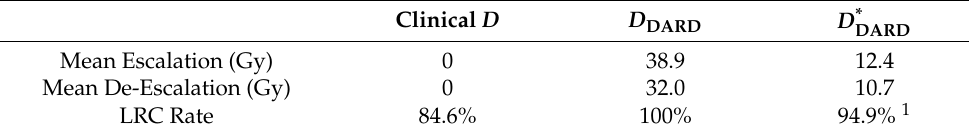
Figure 5. Dose personalization and trial results using D DARD . ( A ). Example calculations of finding minimum RT dose for locoregional control, D DARD , for two patients using 4 tumor volume measurements (1 before start of RT and 4 from weeks 1–4 of RT). Black dots are normalized tumor volume measurements; blue curves the 100 projected tumor volume forecasts; horizontal dashed line the volume reduction threshold associated with LRC; and the vertical dashed line D DARD , the minimum dose where all 100 trajectories are below the LRC threshold. ( B ). Histogram of calculated D DARD values for all 39 patients. ( C ). Waterfall plot of difference between D DARD and the actual dose received in the clinic, where ∆ D > 0 indicates dose escalation and ∆ D < 0 indicates dose de-escalation for the 38 patients on the trial. Individual patient characteristics of interest (primary tumor site, p16 status, T-stage, cumulative dose received in the clinic, and D DARD ) are indicated for each patient below the waterfall plot. Table 1. Summary of dose personalization and estimated effect on